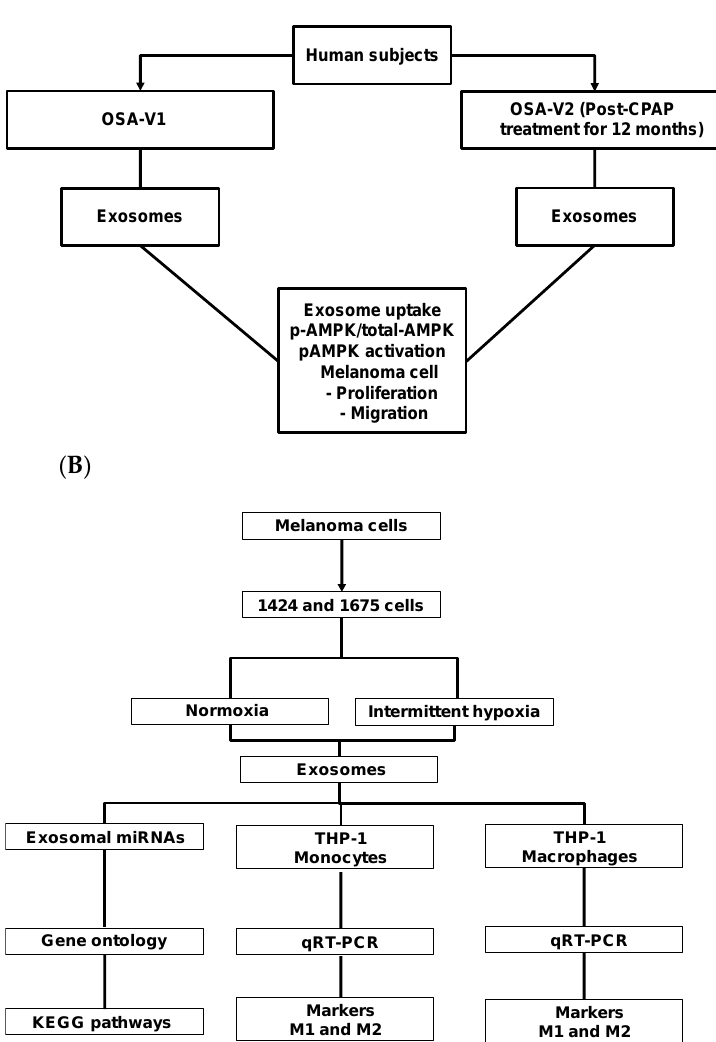
Figure 1. Schema illustrating the experimental design and data analyses. ( A ) Plasma exosomes were isolated and purified from obstructive sleep apnea (OSA) patients either before CPAP treatment (OSA-V1) or after treatment (OSA-V2). ( B ) Diagram illustrating cell culture exposed to normoxia and IH for 48 h, and exosomes characterization, exosomal miRNAs microarrays profiling, Gene Ontology and KEGG